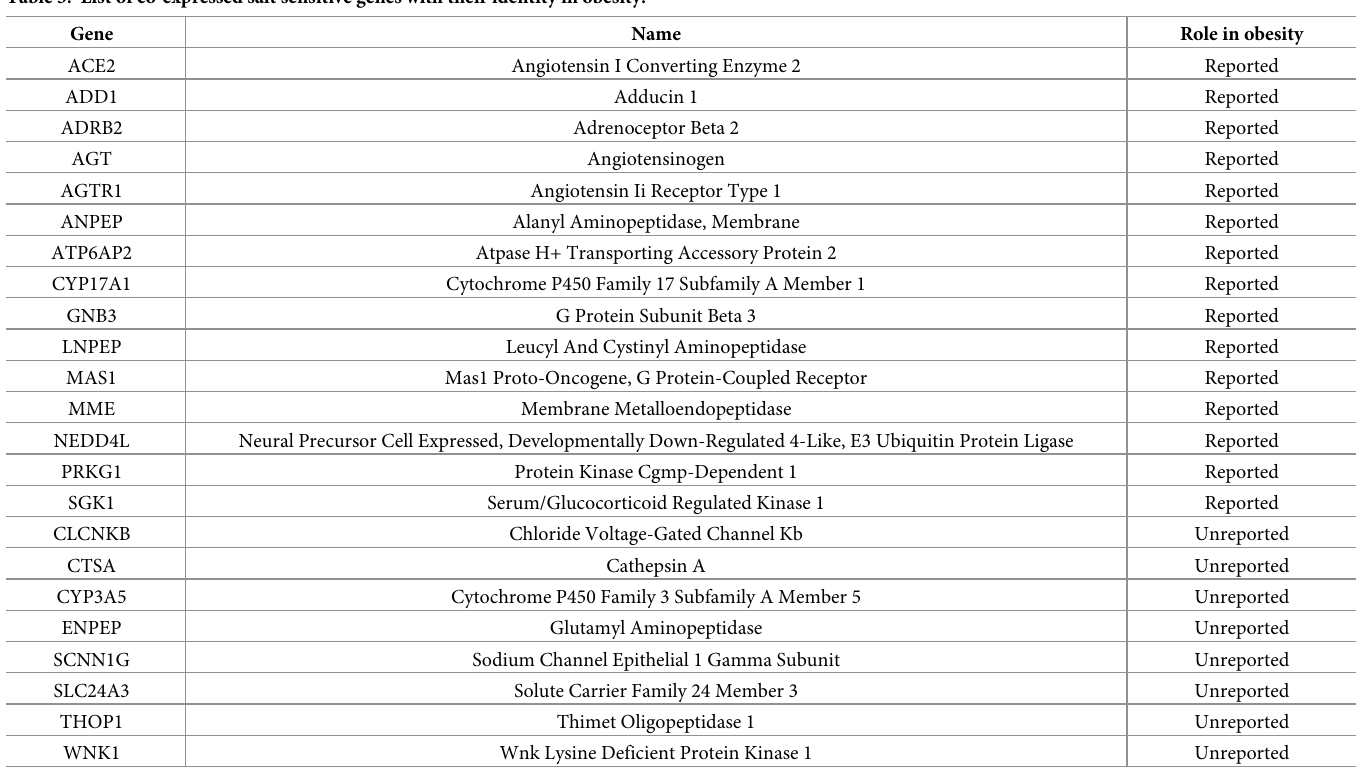
Table 5. List of co-expressed salt sensitive genes with their identity in obesity.